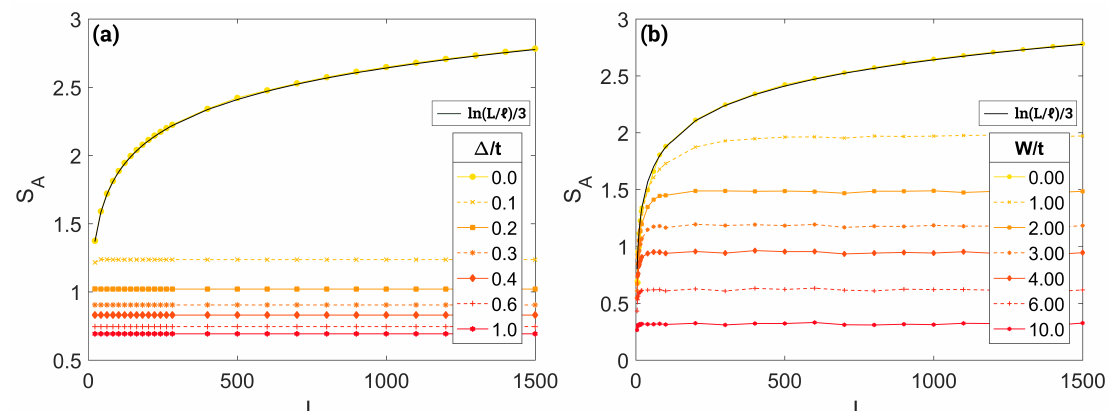
Figure 1. von Neumann entanglement entropy (disorder-averaged over 10 4 samples when W > 0) as a function of the total system size L for L A / L = 1/2, µ = 0, and periodic boundary conditions: ( a ) In the clean case ( W = 0) for different values of ∆ / t ; ( b ) For ∆ = 0 and different disorder strengths W / t . For W = ∆ = 0, a fit to the expected logarithmic critical behavior, Equation (5), is plotted in